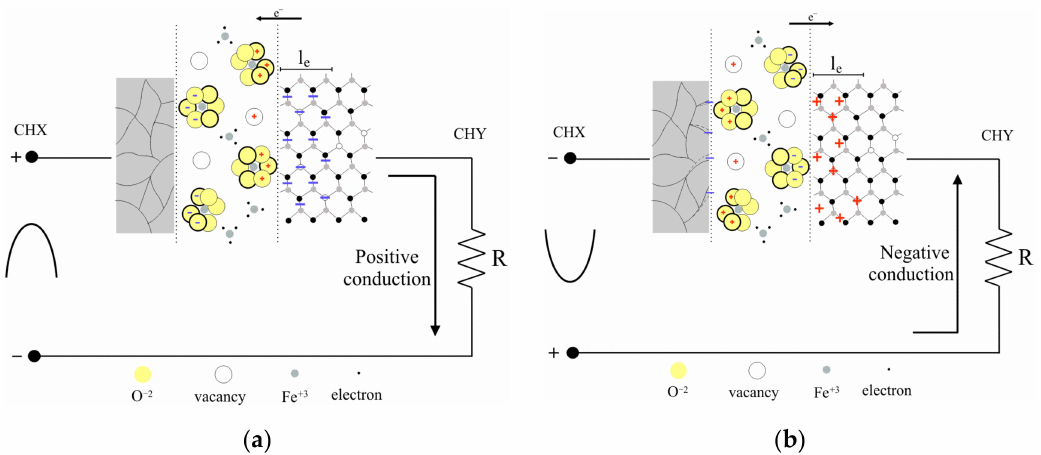
Figure 4. Schematic views to demonstrate conduction and describe physical phenomena inside the Fe–Si steel/ α - Fe 2 O 3 /graphite structure. ( a ) At positive conduction; ( b ) At negative conduction. Figure shows how exchange coupling at each interface depends on many species.